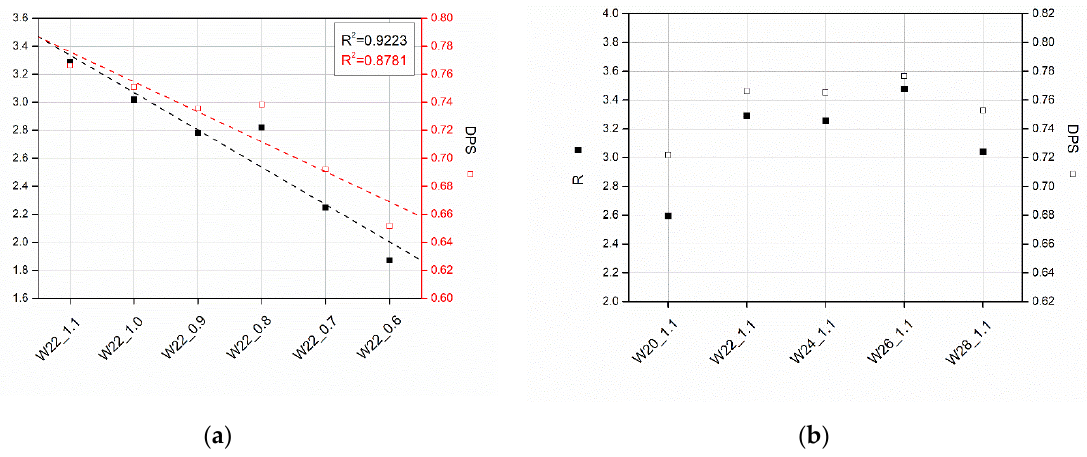
Figure 3. Hydrogen bonding index (R) and degree of phase separation (DPS) calculated on the basis of FTIR spectra for foams obtained with different amounts of water ( a ) and different NCO indices ( b ).